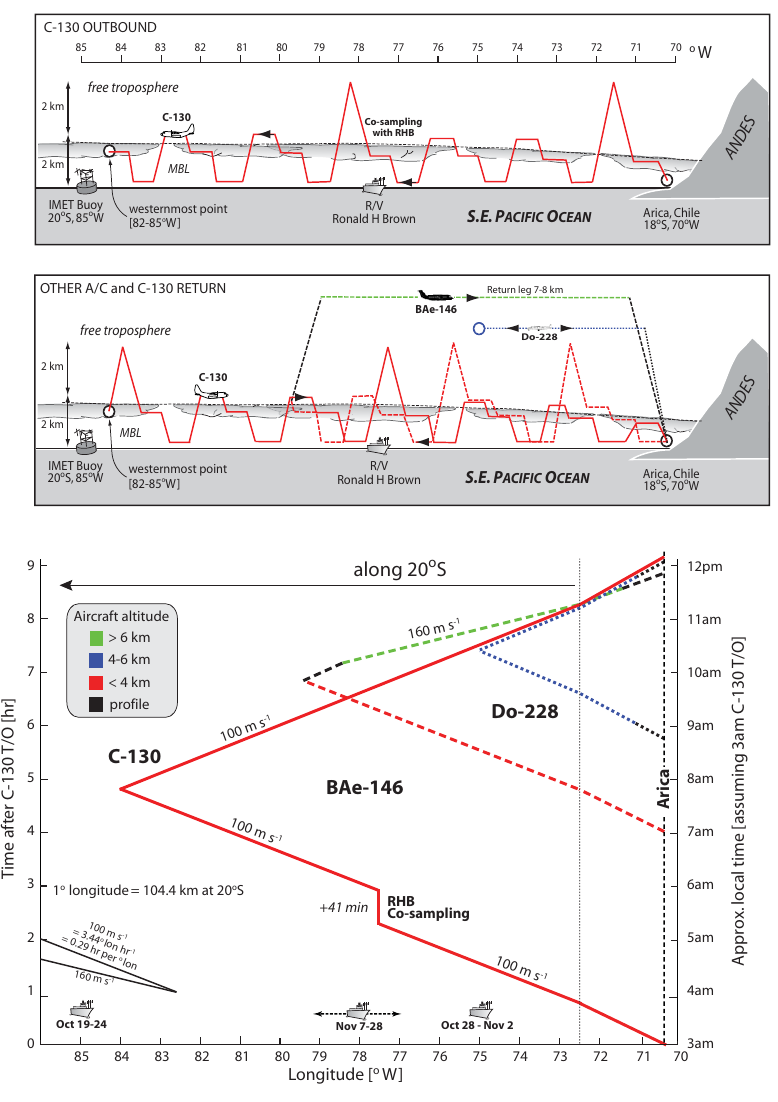
Fig. 5. Cross Section mission flight plan. Up to three aircraft (BAe-146, C-130, Do 228) were used in this mission, but in a number of cases only a single aircraft was used. In all cases, the aircraft flew from Arica to 20 ◦ S, 72 ◦ W and then flew westward along the 20 ◦ S parallel. The schematic shown here is for all three aircraft - the upper two panels show longitude-height diagrams while the lower panel shows a time- longitude plot color coded with altitude range. The C-130 flew 60km (10 min) straight and level legs near the surface (150m altitude), in the cloud (typically 800–1300m altitude) and above cloud (300m above cloud top), interspersed with profiles up to 3000–4000m. The C-130 typically reached 85 ◦ W. The BAe-146 flew similar outbound legs, out to 79–80 ◦ W but then flew the return leg at high altitude releasing dropsondes and making radiation measurements when working in concert with the C-130. When operating alone the BAe-146 repeated the in-situ sampling on the return leg. The Do-228, when employed in this mission, flew legs at approximately 4000m altitude using the nadir-viewing lidar and hyperspectral imagers to characterize clouds and aerosols below. There was a concerted effort for the three aircraft to sample the same location as closely in time as possible on the return leg (see bottom